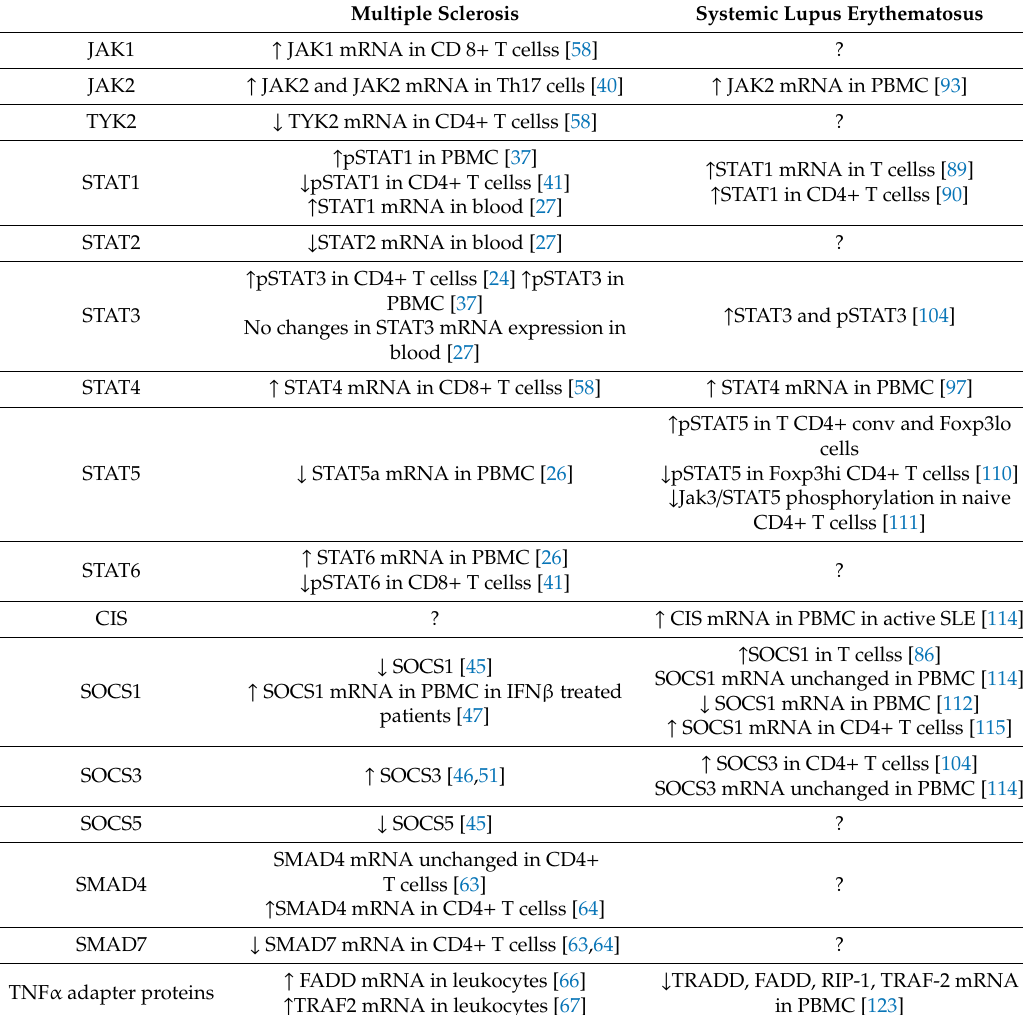
Table 1. Comparison of quantitative alterations in proteins of JAK-STAT, TGF- β and TNF α signaling pathways in multiple sclerosis and systemic lupus erythematosus. Arrows indicate a decrease / an increase and “?”—no data. A “p” denotes a phosphorylated